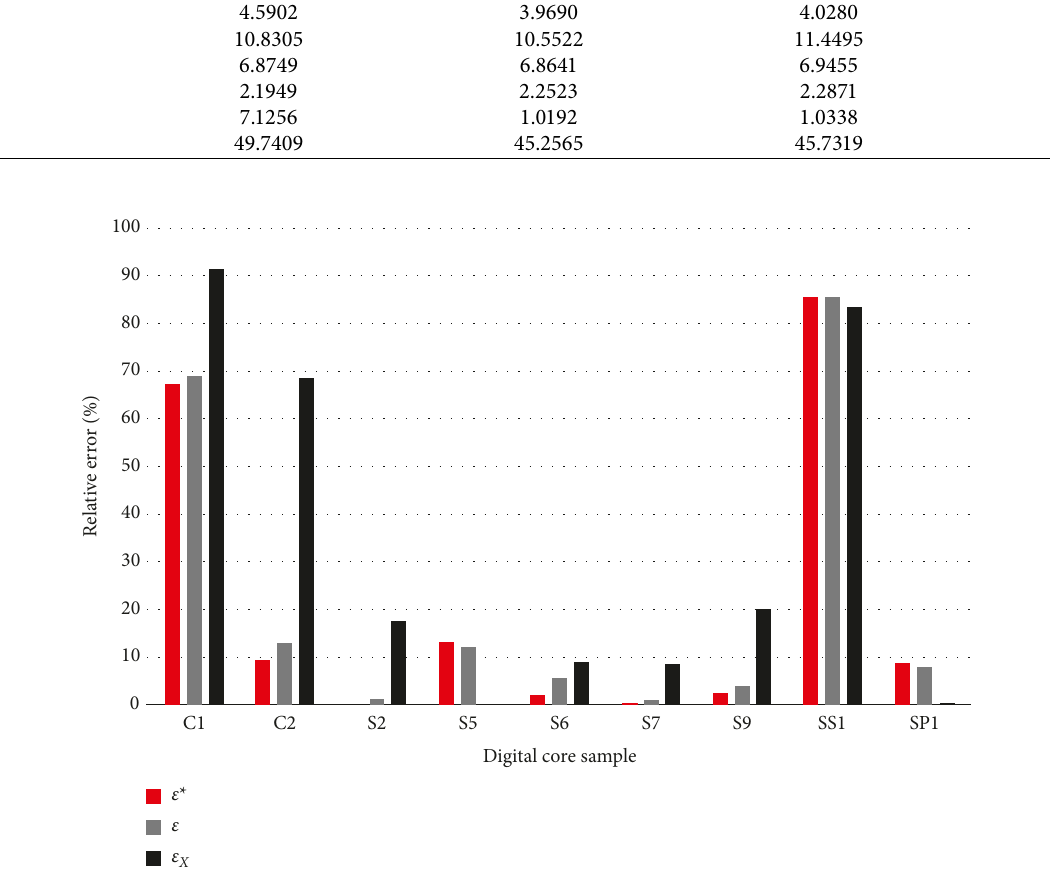
K ∗ , K,K X and the